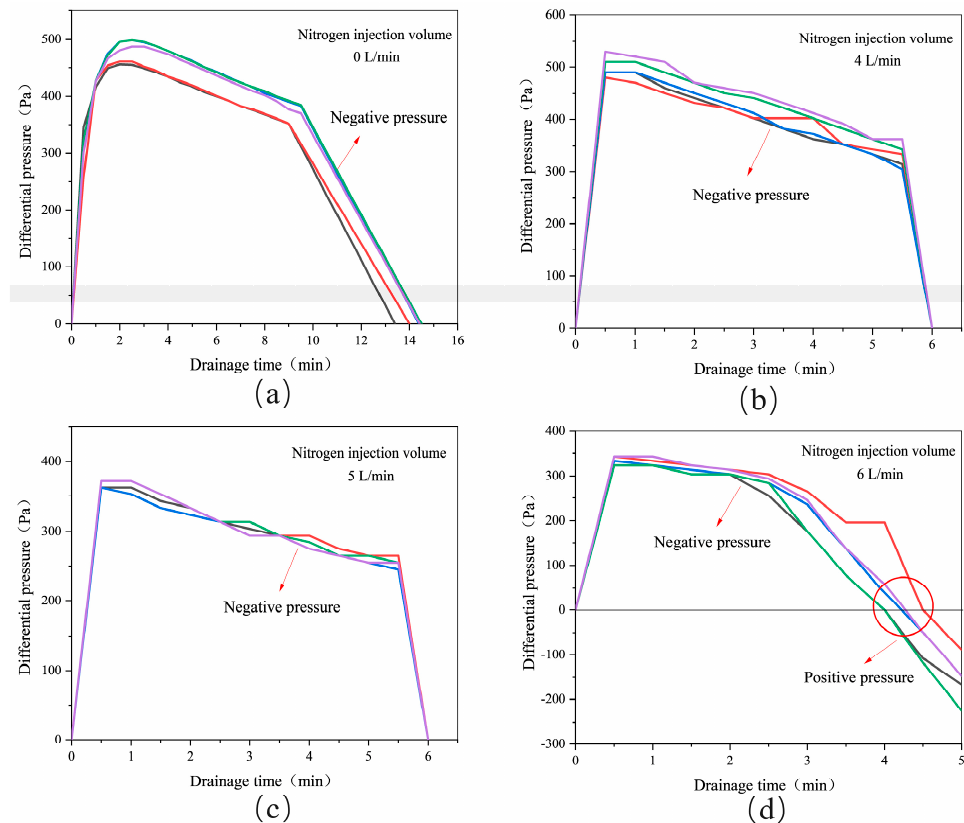
Figure 4. ( a ), ( b ), ( c ) and ( d ) are respectively the internal and external pressure difference changes of nitrogen injection amount in goaf at 0 L/min, 4 L/min, 5 L/min, and 6 L/min.